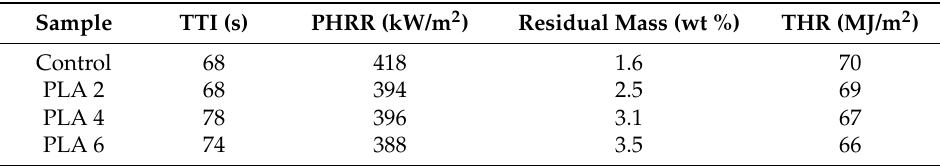
Table 8. Cone calorimetry data for PLA– 28 blends.